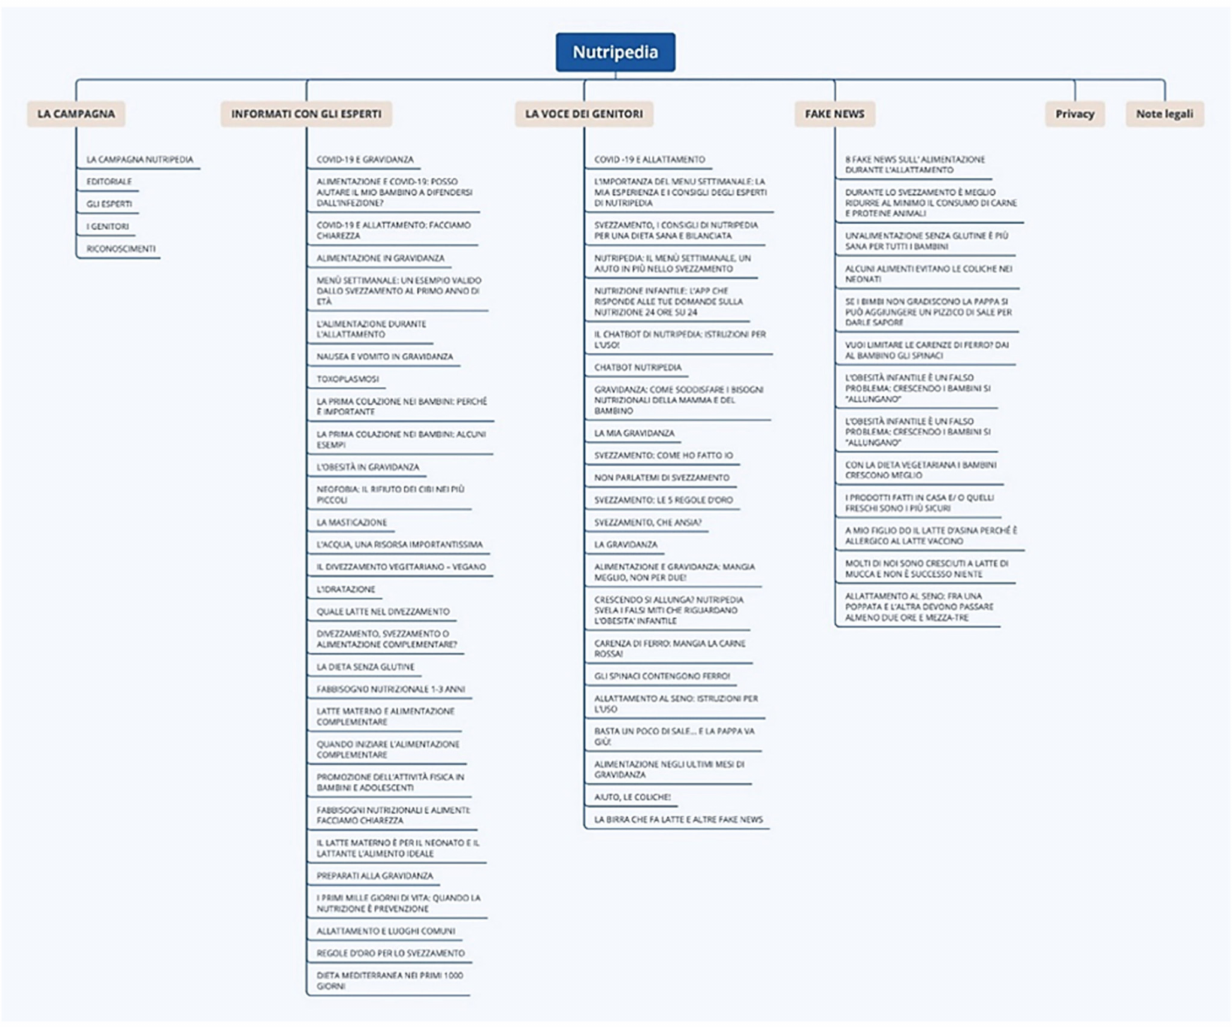
Figure 2. Navigation flow of Nutripedia website. The navigation flow of Nutripedia is divided into six sections “The campaign”, “The expert voices”, “The parents’ voices”, “Fake News”, “Privacy” and “Legal Information” respectively. Specific web-articles for each topic are listed in the scheme (for instance COVID-19 and pregnancy for “The expert voices” topic or Complementary feeding: my personal experience for “The parents’ voices” topic and 8 fake news about nutrition during breastfeeding for “Fake News”